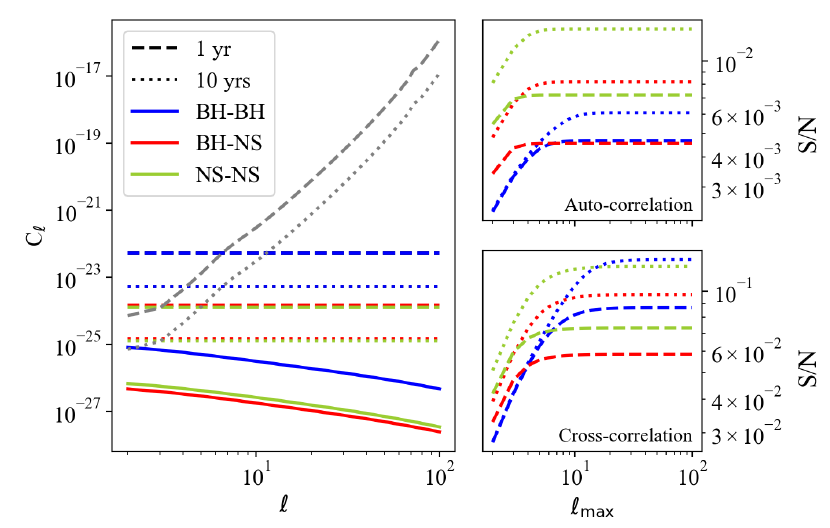
Figure 5. Left panel: the grey lines represent noise curves N (cid:96) for the extended network given by LIGO/Virgo/Kagra + ET + CE, for two different integration times: T = 1 yr (dashed) and T = 10